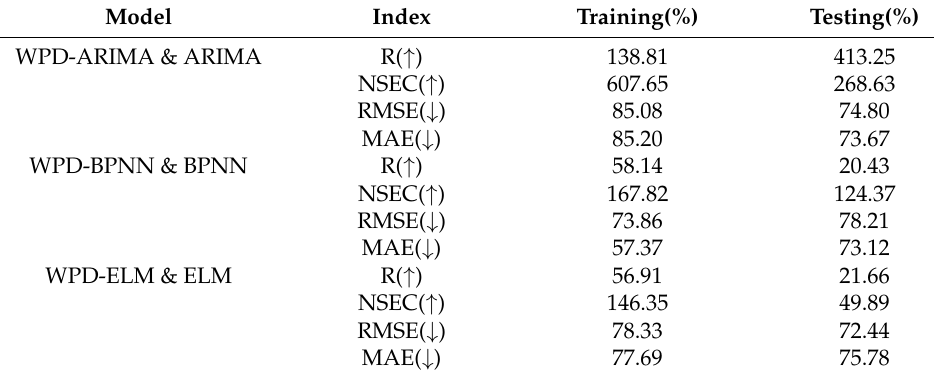
Table 5. Comparison of model prediction performances.